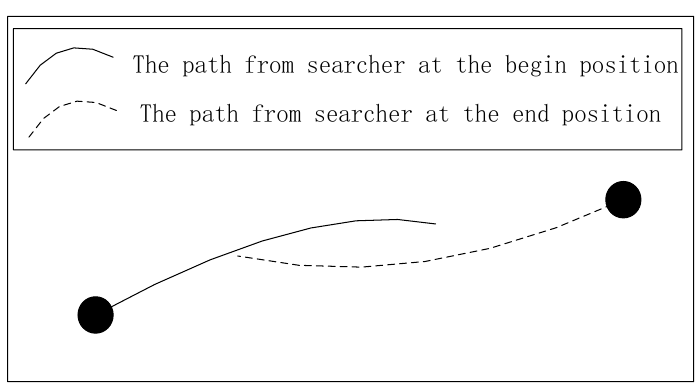
Figure 8. Two paths overlap. Figure 8. Two paths